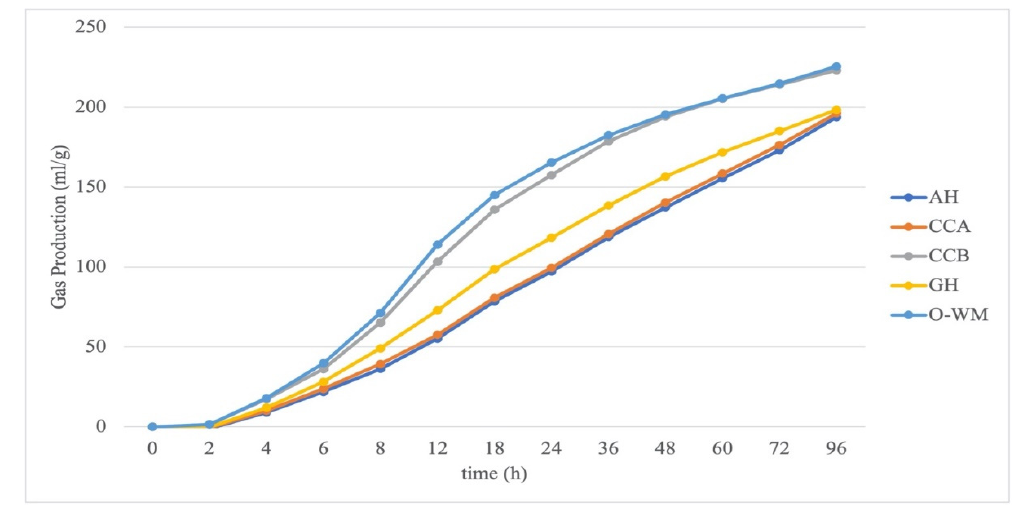
Figure 1. In vitro gas production kinetics of ingredients. AH: alfalfa hay, CCA: starch-based commercial concentrate, CCB: commercial concentrate with soluble fiber sources, GH: grass hay; O-WM: 50% oats and 50% wheat middlings. Table 2. In vitro GP parameters and concentrations of volatile fatty acids produced in the fermentation of the pure ingredients used for the experimental